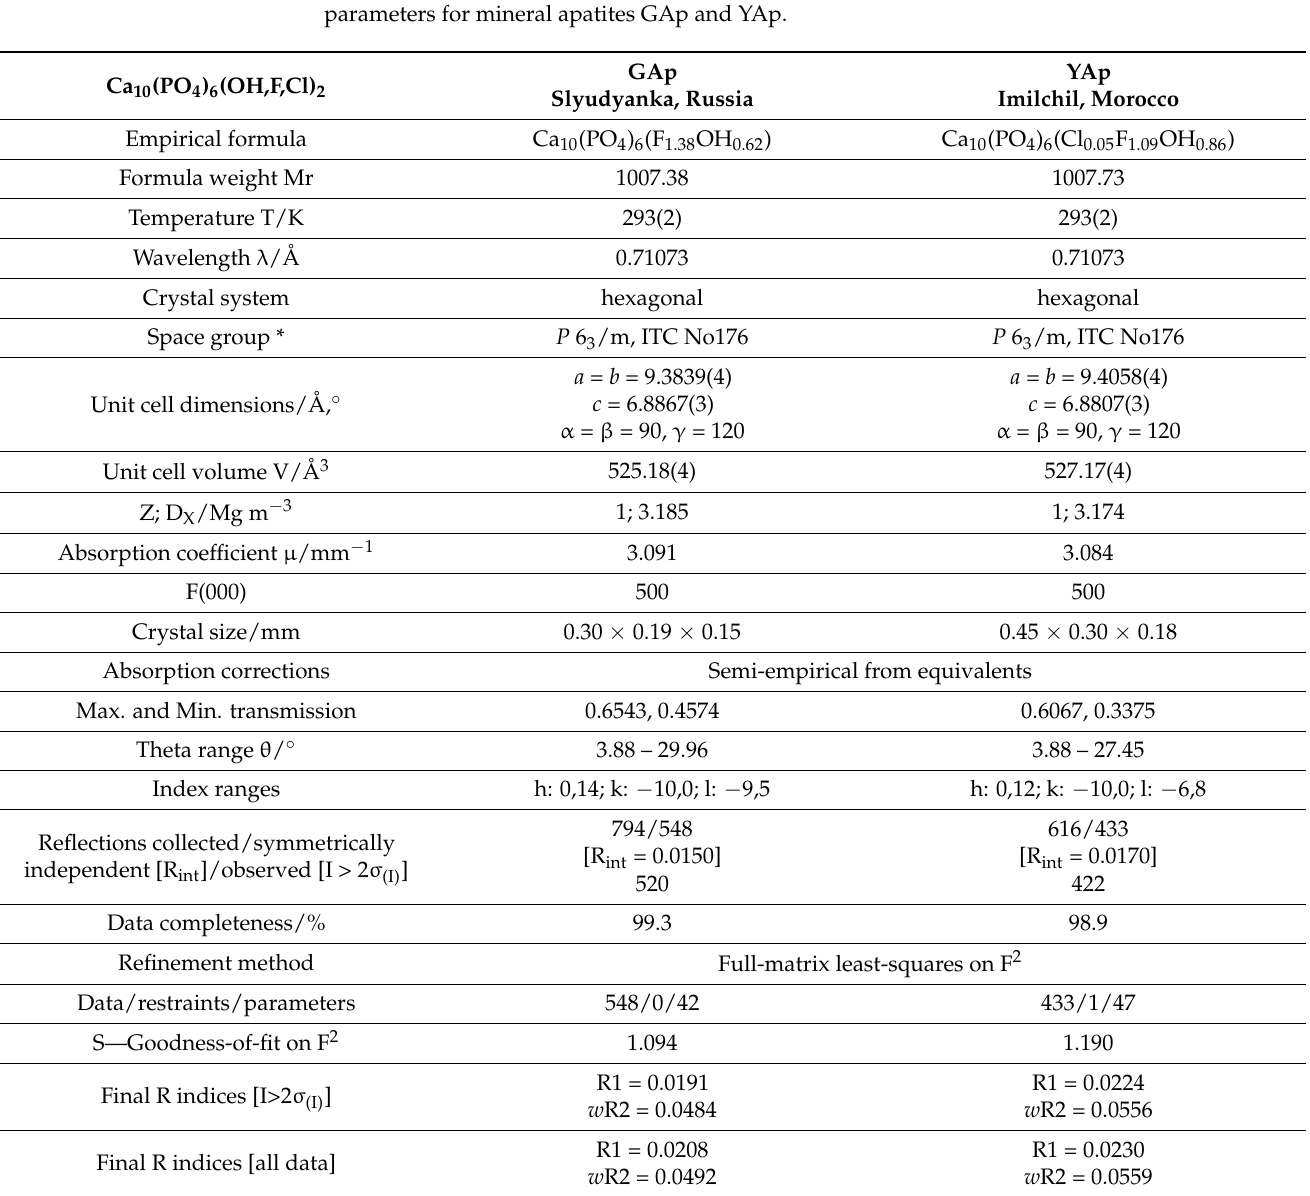
Table A2. Crystallographic data, diffraction measurement conditions and structure